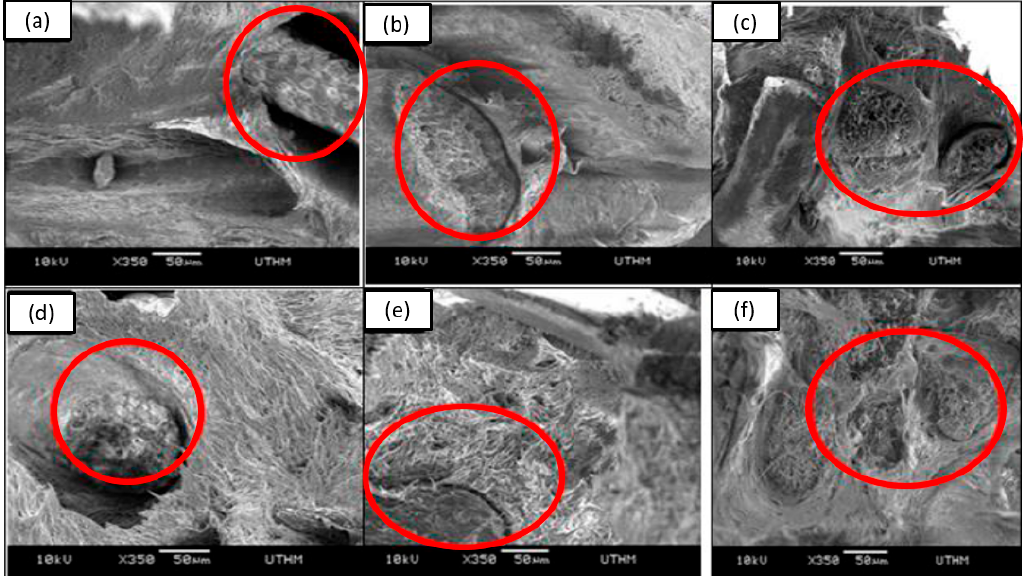
Figure 2. SEM analysis of fractured SPF-reinforced propylene composites with ( a ) 10 wt%, ( b ) 20 wt%, ( c ) 30 wt% of untreated SPF; ( d ) 10 wt%, ( e ) 20 wt%, ( f ) 30 wt% of silane treated SPF. Adapted with permission from Ref. [148]. Copyright Elsevier.